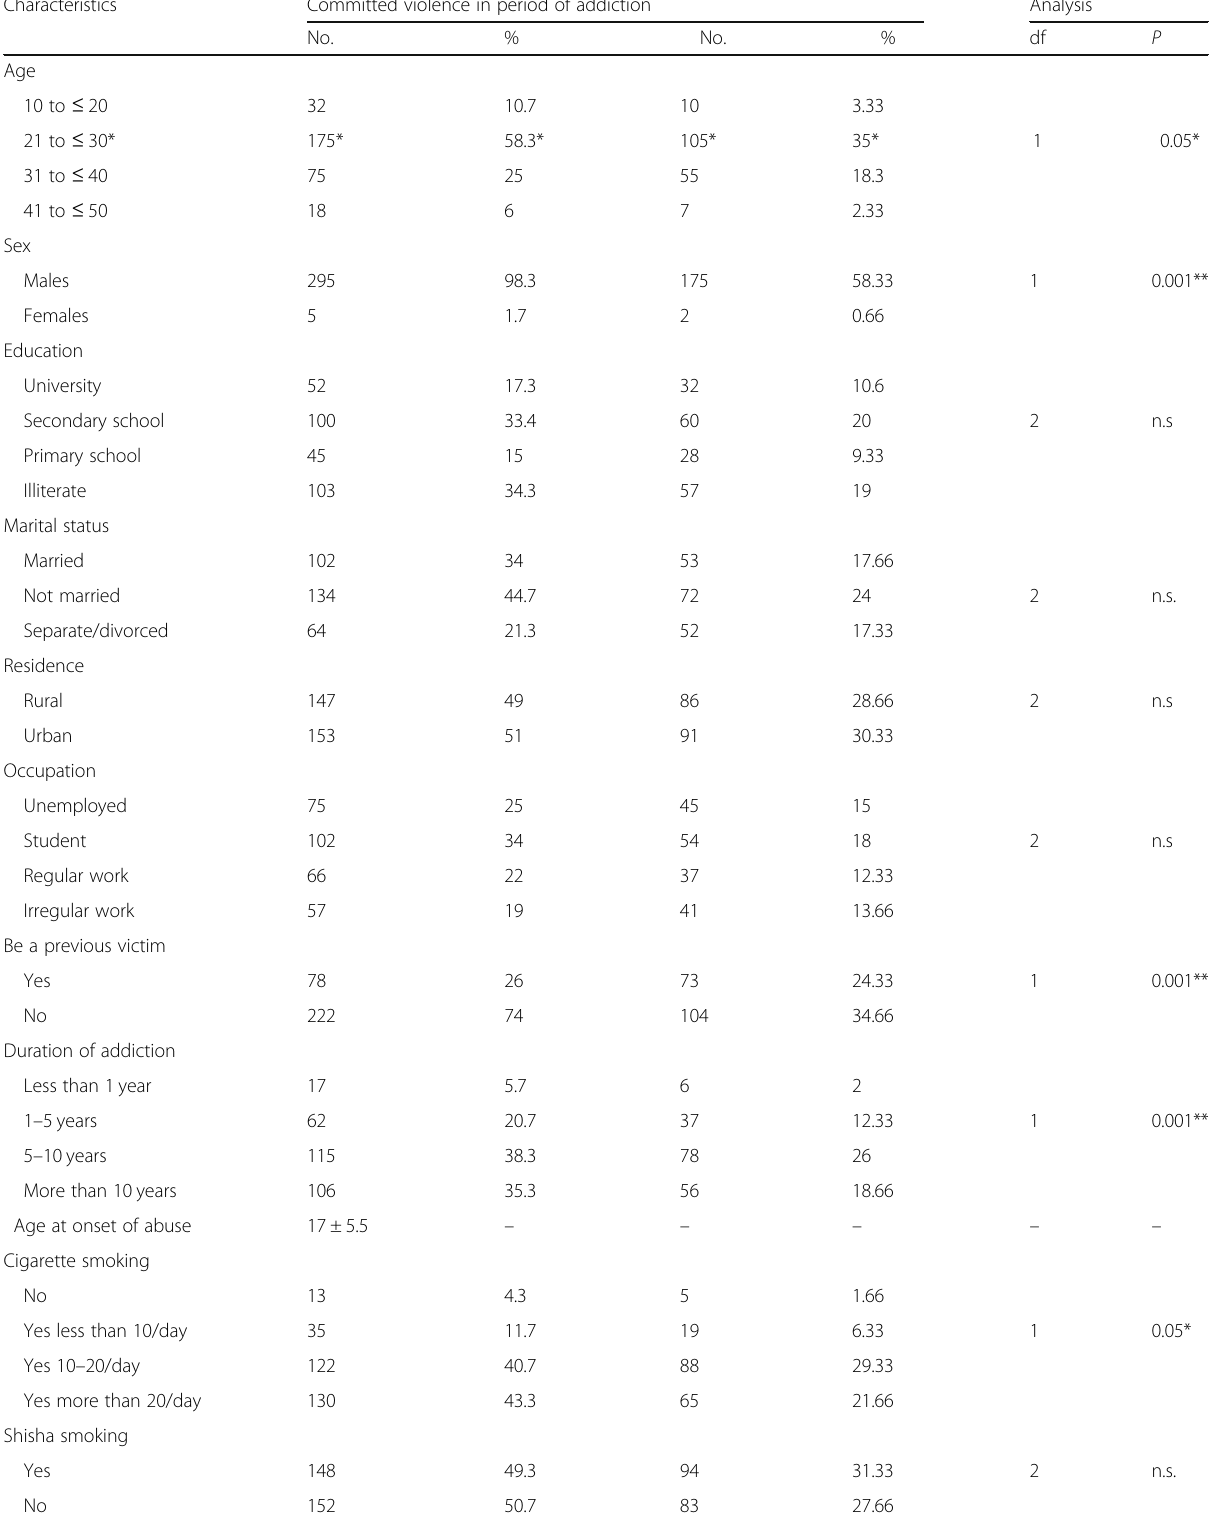
Table 2 Sociodemographic characteristics of the studied addict patients and the relation to violence within the period of addiction